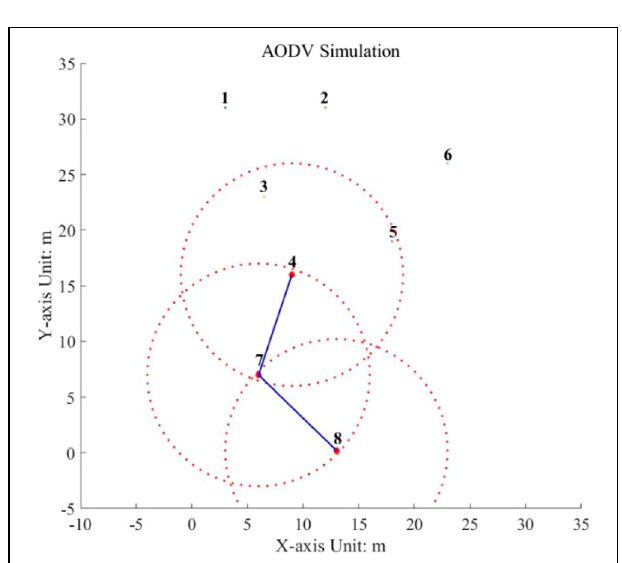
FIGURE 8 | Routing simulation diagram from node 8 to node 4.